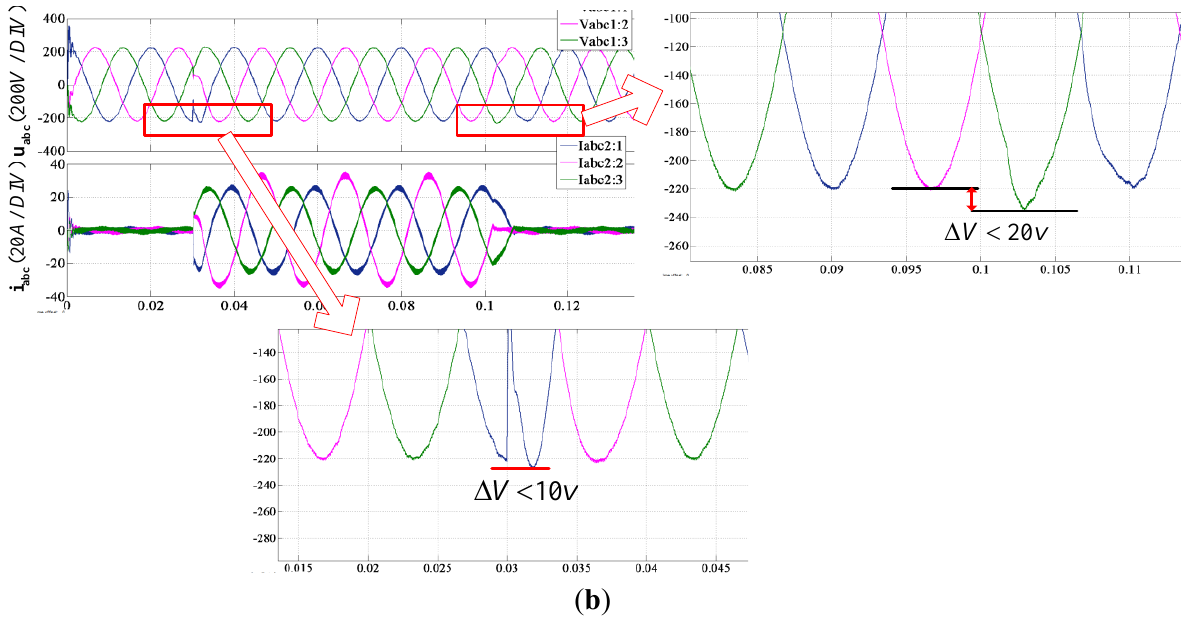
Figure 14. Simulation results of the propose control strategy under Scenario 2: ( a ) without LCO; ( b ) with LCO.